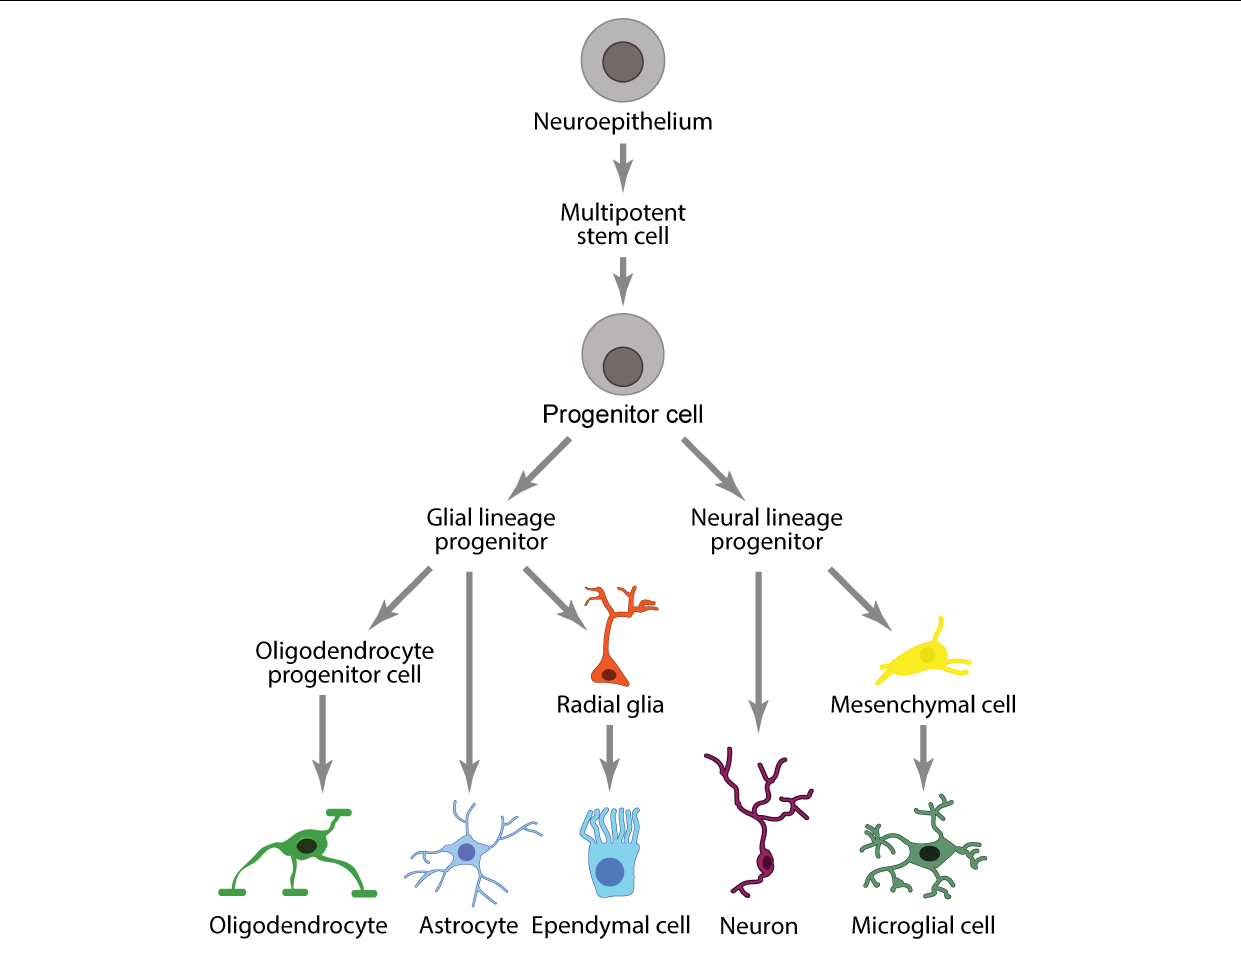
FIGURE 4 | Immune cell lineages in the